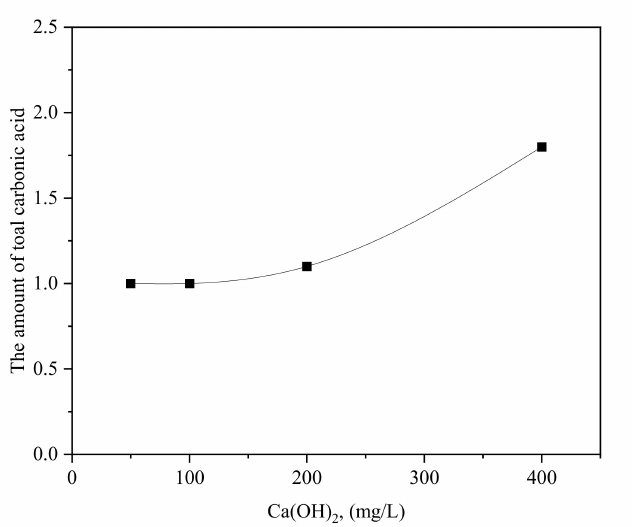
Figure 6. Relation between the amount of total carbonic acid and Ca(OH) 2 content in solution. With regard to effect of Ca 2+ on concentration of CO 2 (aq), a part of Ca 2+ in solution might remain in the medium, so it could not be completely absorbed by Nannochloropsis sp. In order to test effect of Ca 2+ on concentration of CO 2 (aq), the concentrations of Ca 2+ (Figure 2) in F/2 medium after the addition of converter slag and EAF slag leaching solutions before and after culturing Nannochloropsis sp. were tested, and concentrations of Mg 2+ under the same condition were listed to be used for